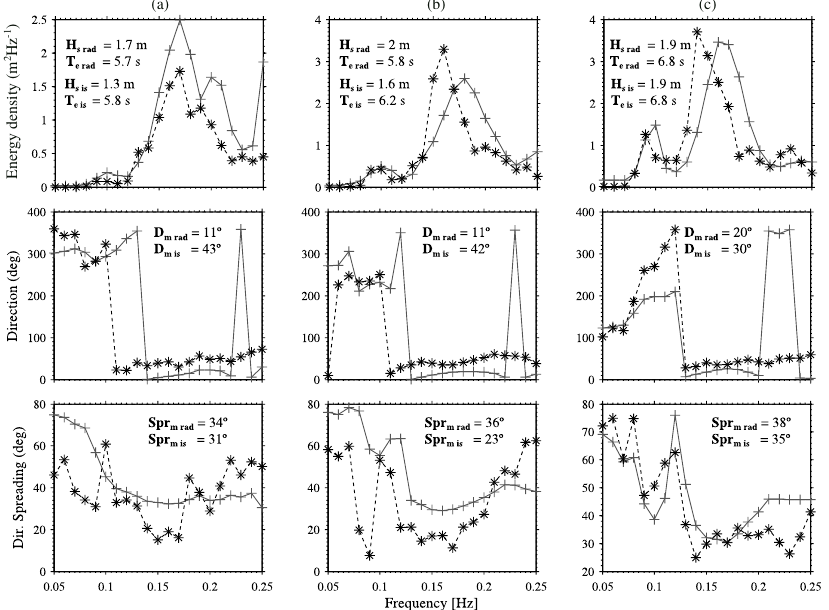
Figure 10. As in Figure 6, on 26 October 2012 at 0100